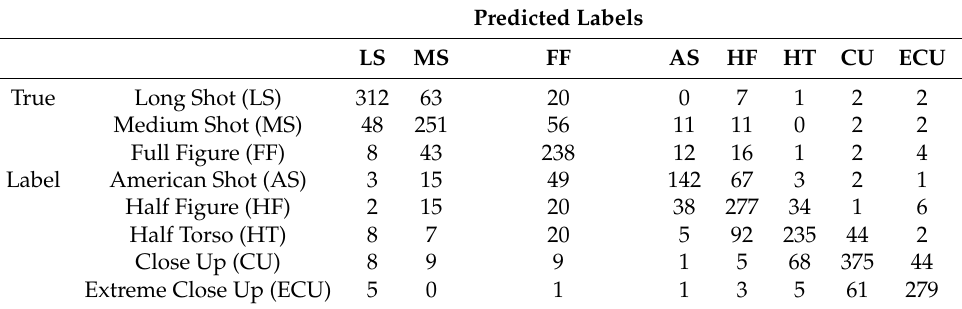
Table 4. Confusion Matrix of a VGG-16 trained on the Hyper